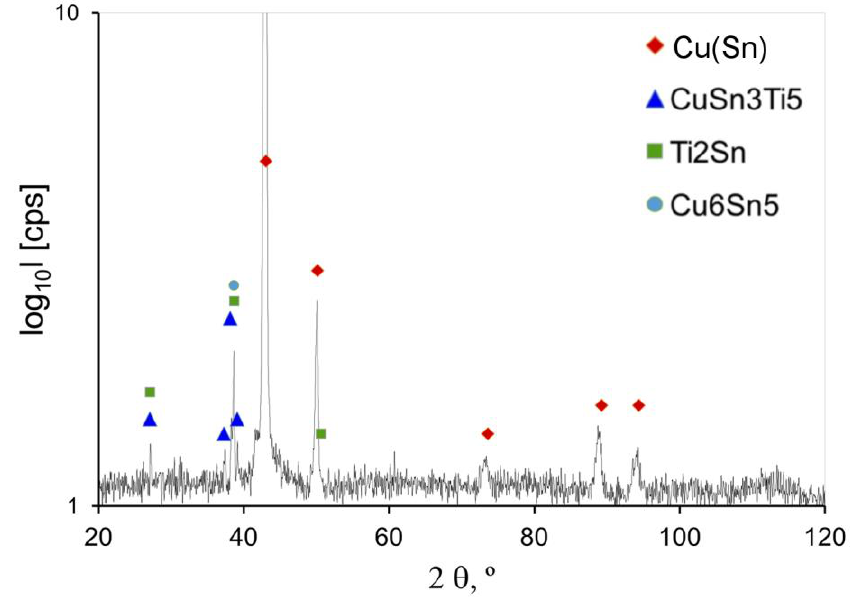
Figure 8. Powder diffraction spectrum of the CuSn8Ti2 alloy.